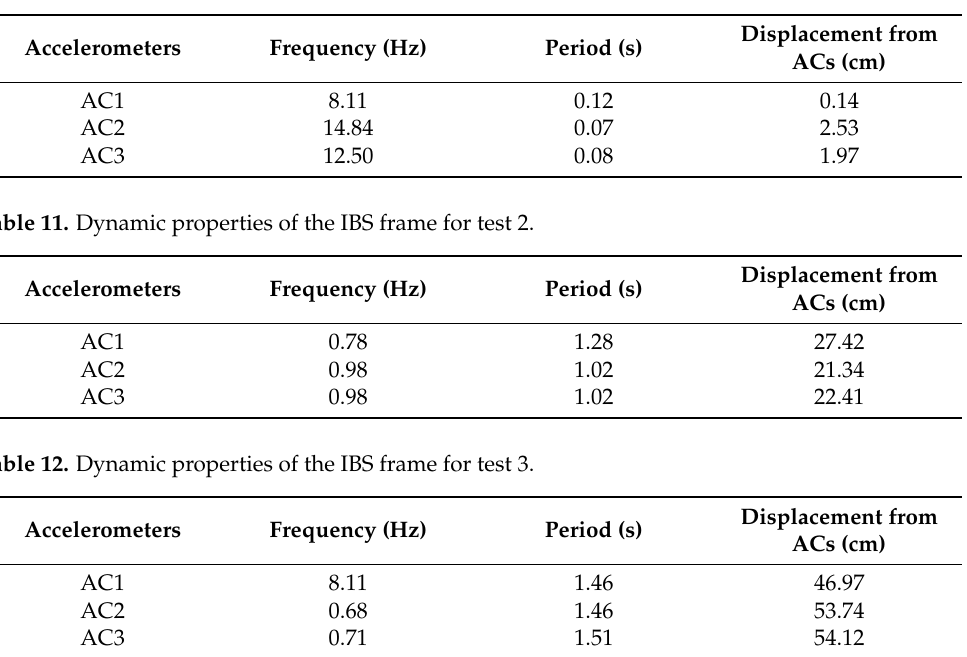
Table 10. Dynamic properties of the IBS frame for test 1.